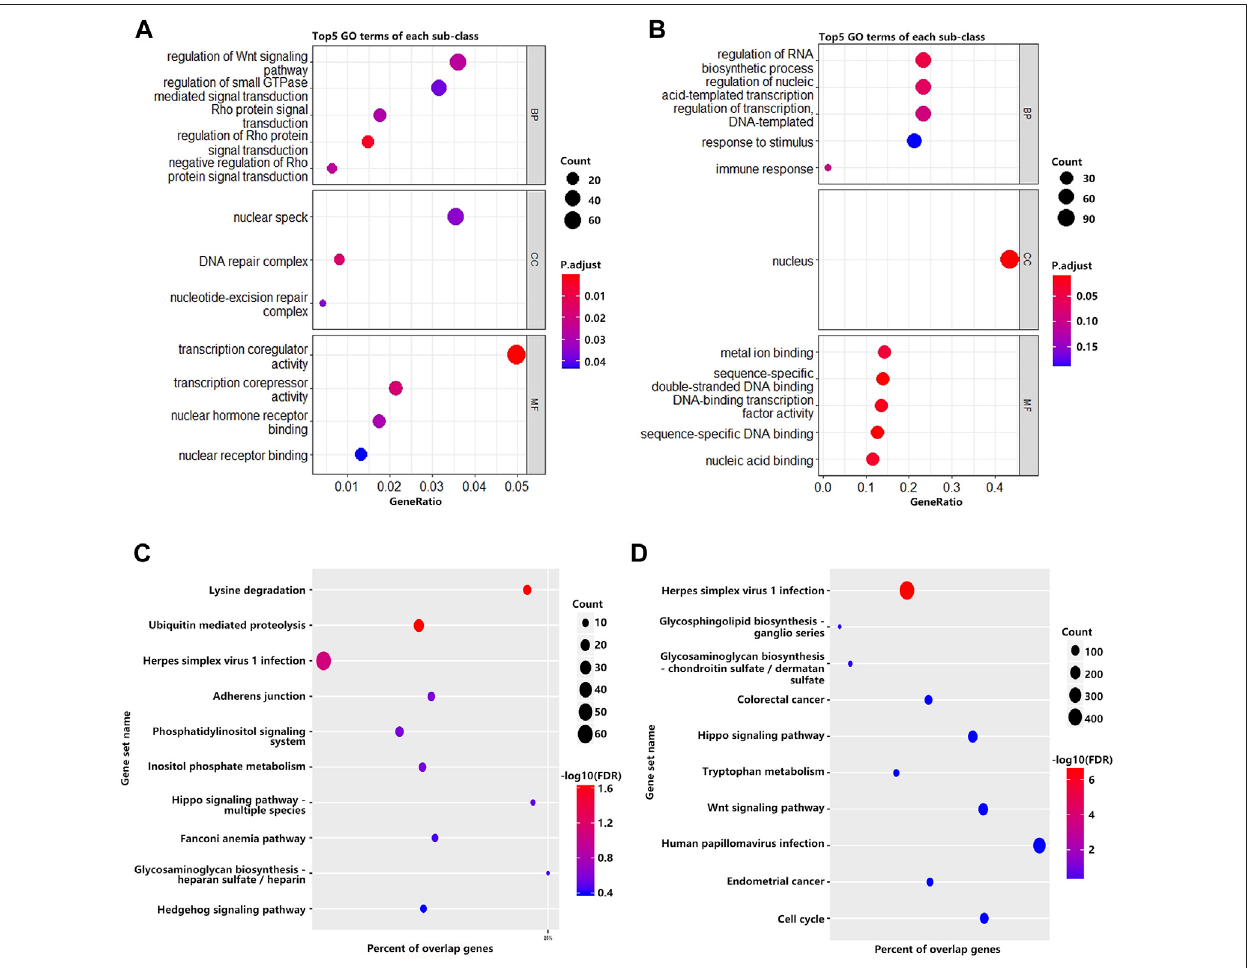
FIGURE 2 | GO and KEGG pathway enrichment analyses of differentially methylated mRNA. (A) The top 5 GO terms of genes with signi fi cantly upregulated m 6 A peaks. (B) Thetop5GOtermsofgeneswithsigni fi cantlydownregulatedm 6 Apeaks. (C) Thetop10KEGGpathwaysofgeneswithsigni fi cantlyupregulatedm 6 Apeaks. (D) The top 10 KEGG pathways of genes with signi fi cantly downregulated m 6 A peaks.